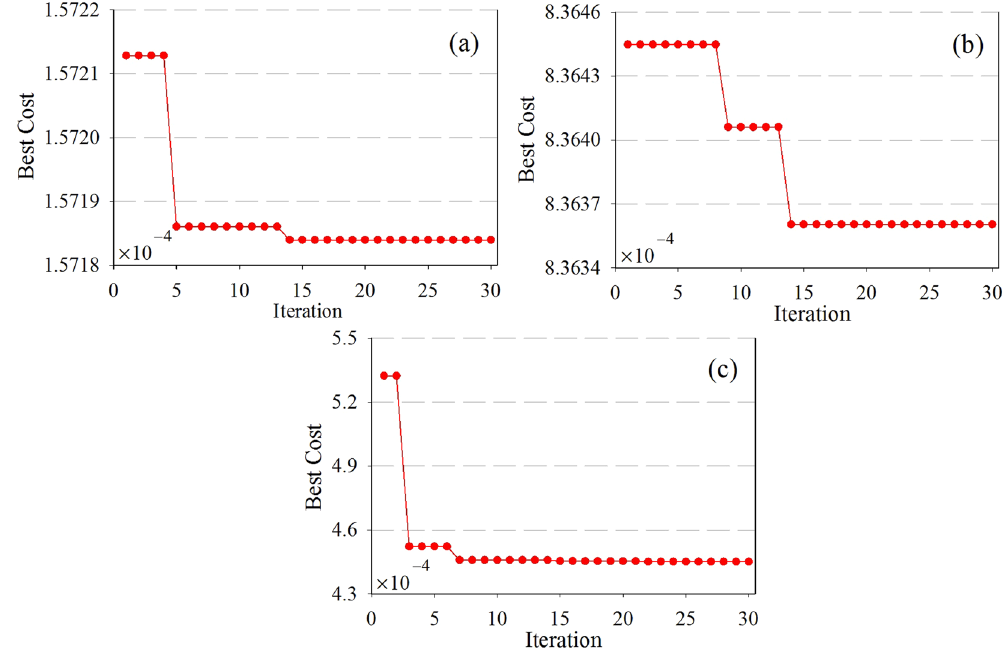
Figure 7. The parameters searching process for the three sub-sequences predictions: ( a ) the low-frequency, ( b ) the 1st high-frequency, and ( c ) the 2nd high-frequency.